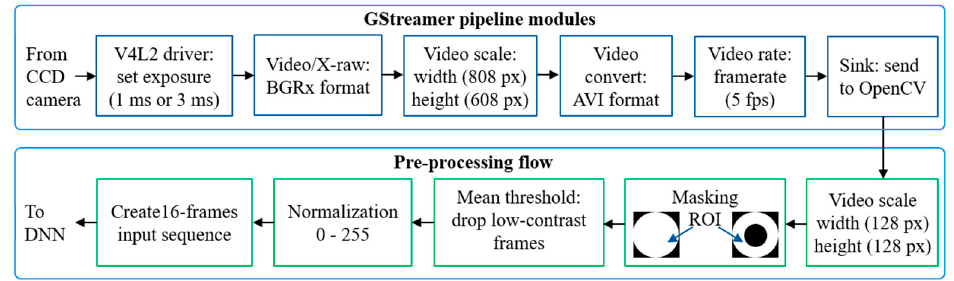
Figure 4. Flow-diagram visualizing the sequence of steps performed in scintillation frames pre-processing in the TurbNet sensors.